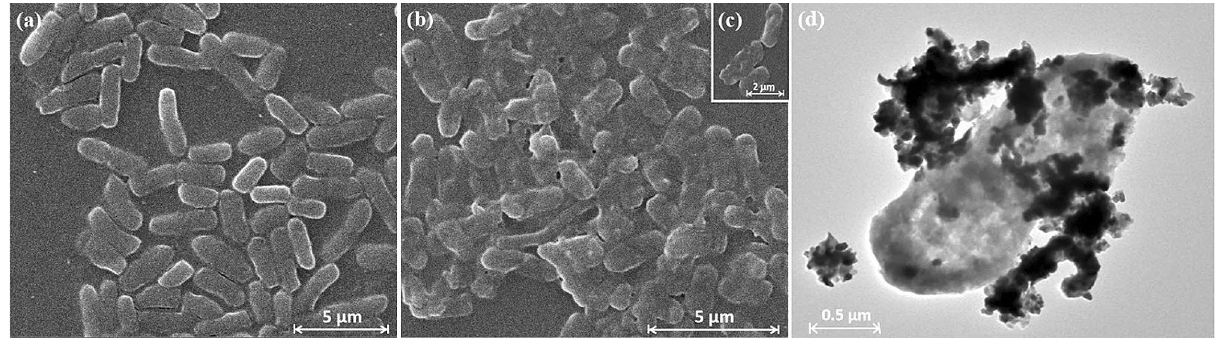
Figure 6. E-SEM images of E. coli cells ( a ) before and ( b ) after sterilization and a partial enlargement (inset) co-culturing with